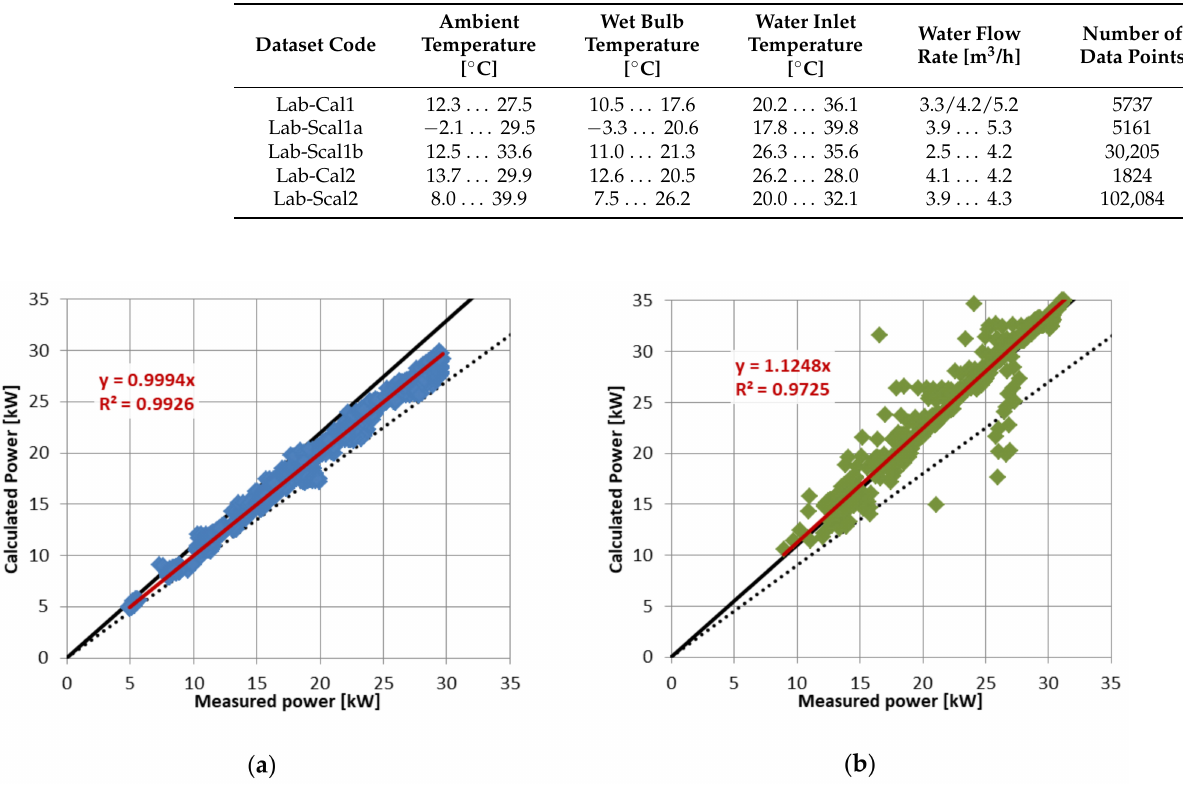
Figure 5. ( a ) Result of model calibration prior to scaling test 1 (dataset Lab-Cal1); ( b ) Comparison of measured and calculated cooling tower power after one year of operation (dataset